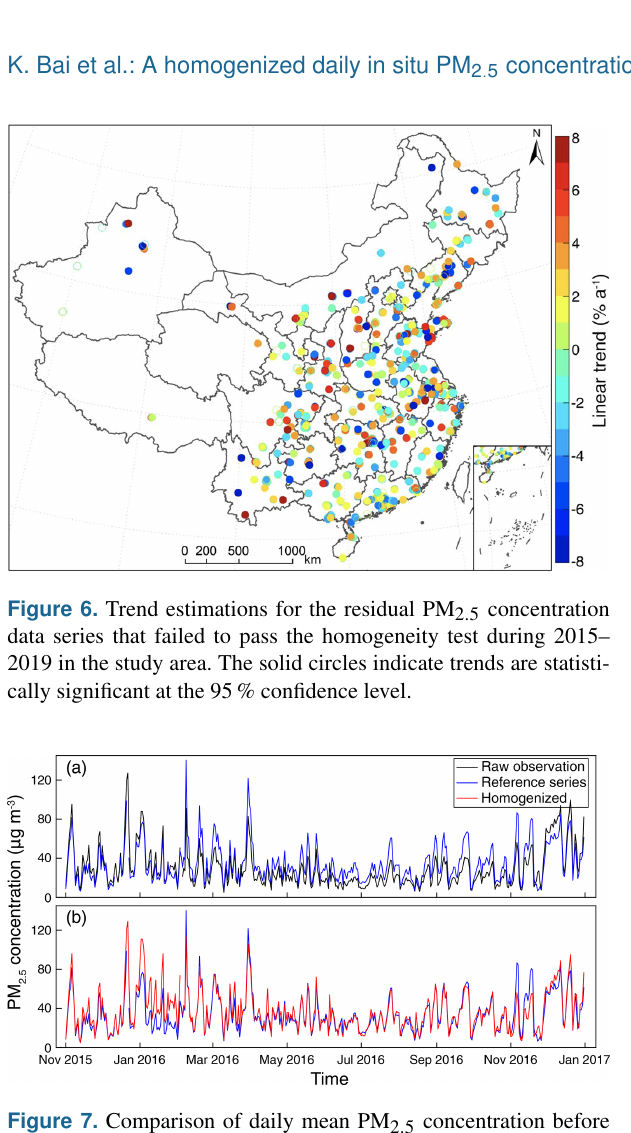
Figure 7. Comparison of daily mean PM 2 . 5 concentration before and after homogenization at one monitoring site in Guangdong province (24.69 ◦ N, 113.60 ◦ E) from November 2015 to December 2016 (large drifts shown in Fig.